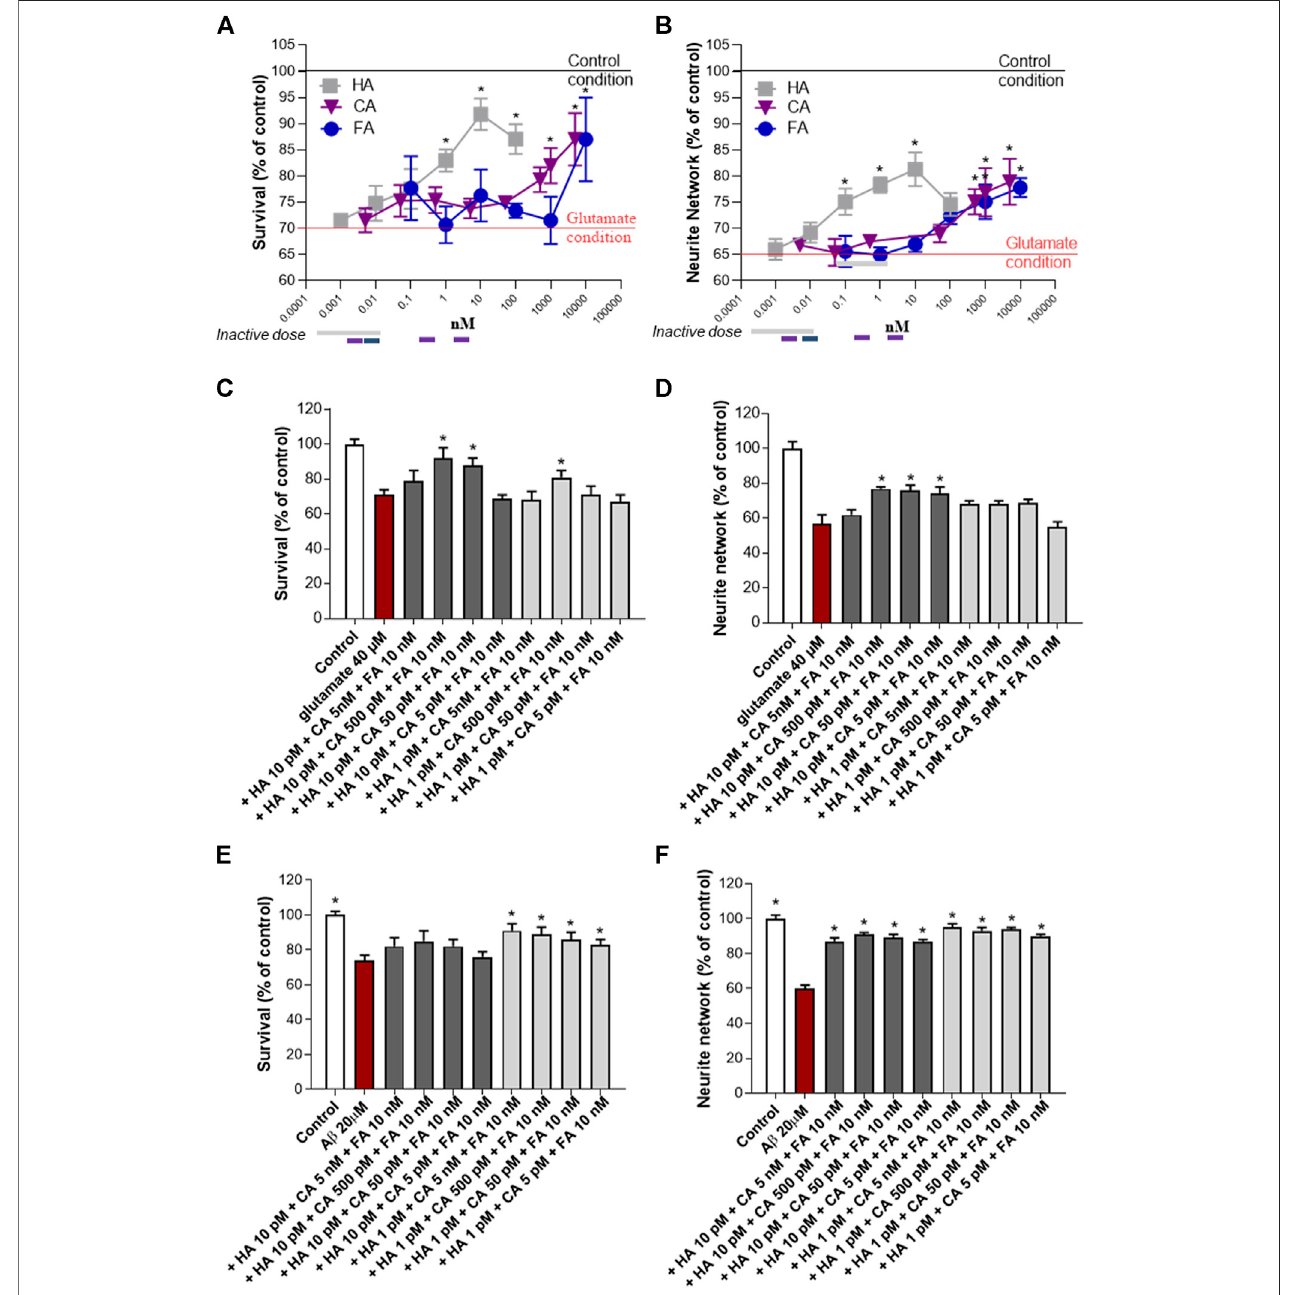
FIGURE3| HA,CAandFAsynergisticallypromoteneuroprotectionafterglutamatergicoramyloidstress.NeuroprotectiveactivityofHA,CAandFAalone (A,B) or a combination of them on neuron survival and neurite network was measured by MAP-2 immunohistochemistry after glutamate (C, D) or A β O (E, F) injury. All values are expressed as mean ± SEM (standard error of the mean). * p < 0.05 vs. control; # p < 0.05 vs. glutamate.